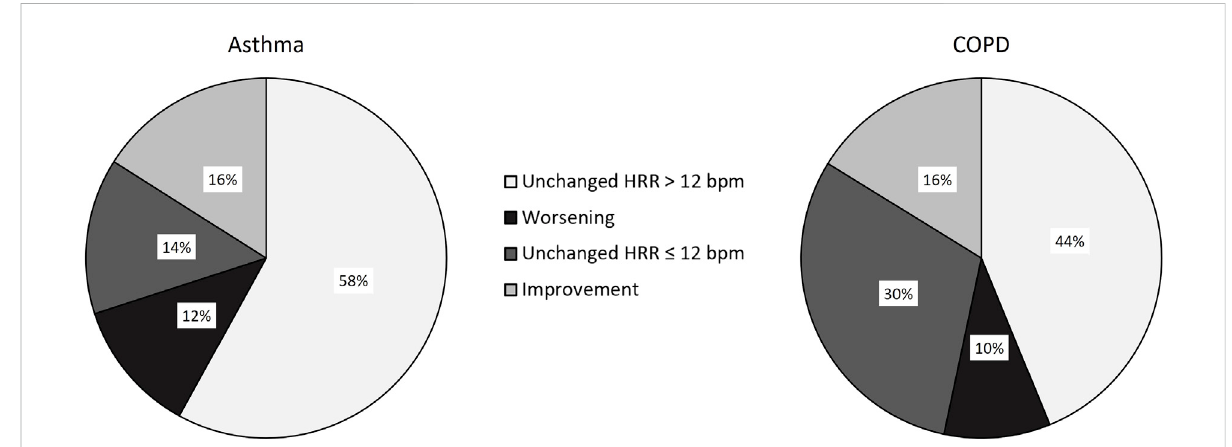
FIGURE 2 Changes in prevalence of HRR post-pulmonary rehabilitation in subjects with asthma and COPD.